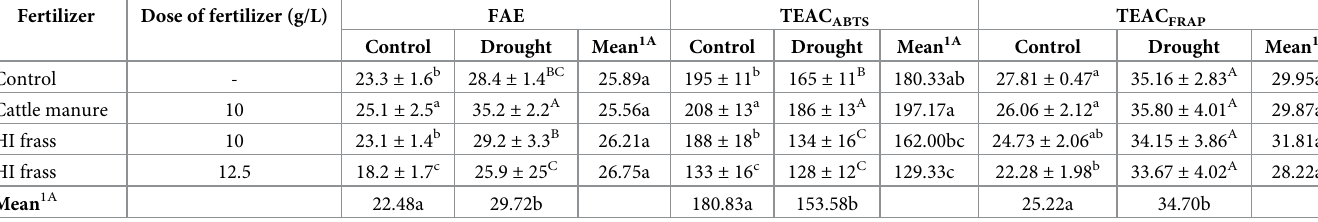
Table 5. Minerals composition of basil cultivated under various water regimes and under various fertilizer formulations.